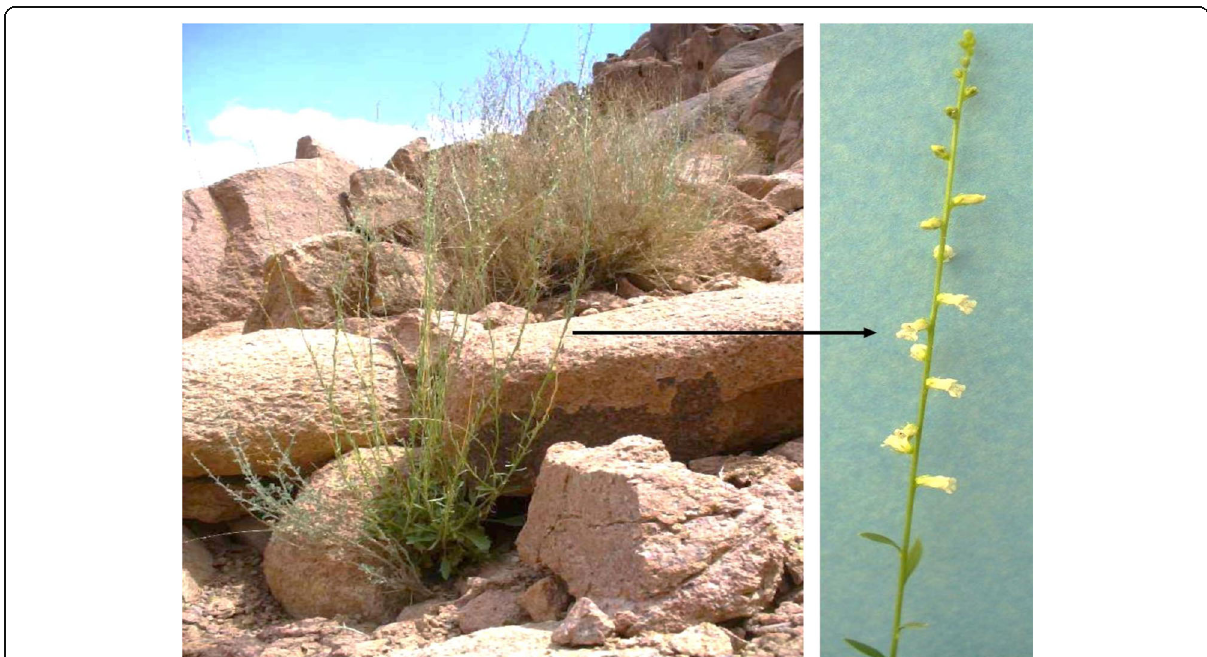
Fig. 1 Anarrhinum pubescens wild